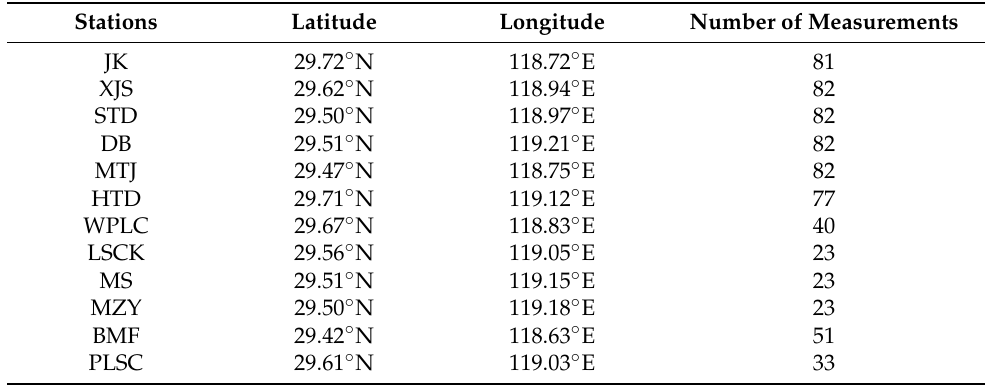
Figure 2. Monthly ( a ) and histogram ( b ) distributions of in situ SDD measurements during 2013–2019. Table 1. Details about in situ SDD (Secchi disk depth) measurement